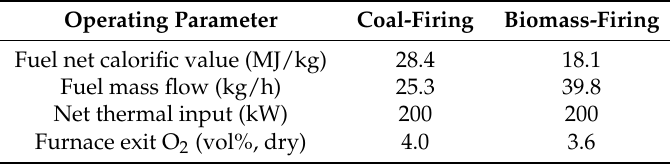
Figure 1. Schematic of the combustion test facility (CTF), identifying the main components and inductively coupled plasma (ICP) sampling location. Table 2. Operating conditions for the CTF during the coal and biomass firing tests.